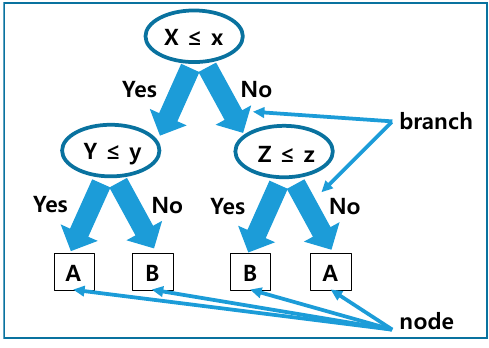
Figure 2. Schematic diagram of classification. Independent variables are X, Y, and Z, and dependent variables are classified as A and B.